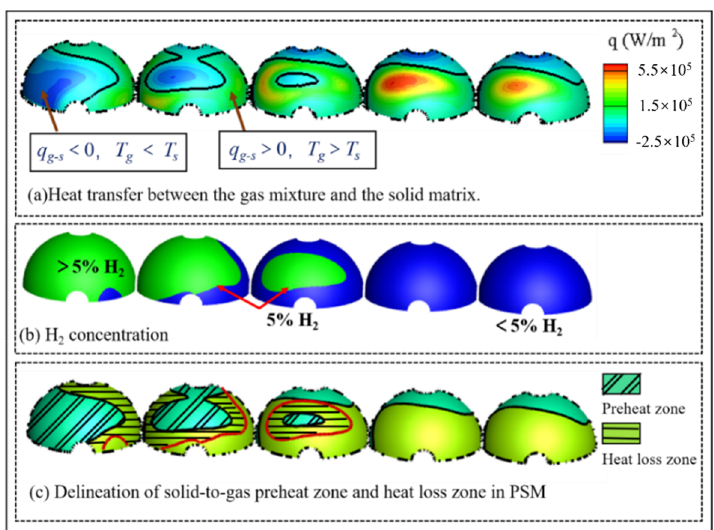
Figure 6. Delineation of solid-to-gas preheat zone and heat loss zone obtained by the PSM, with U 0 = 2 m/s and Φ = 0.65.